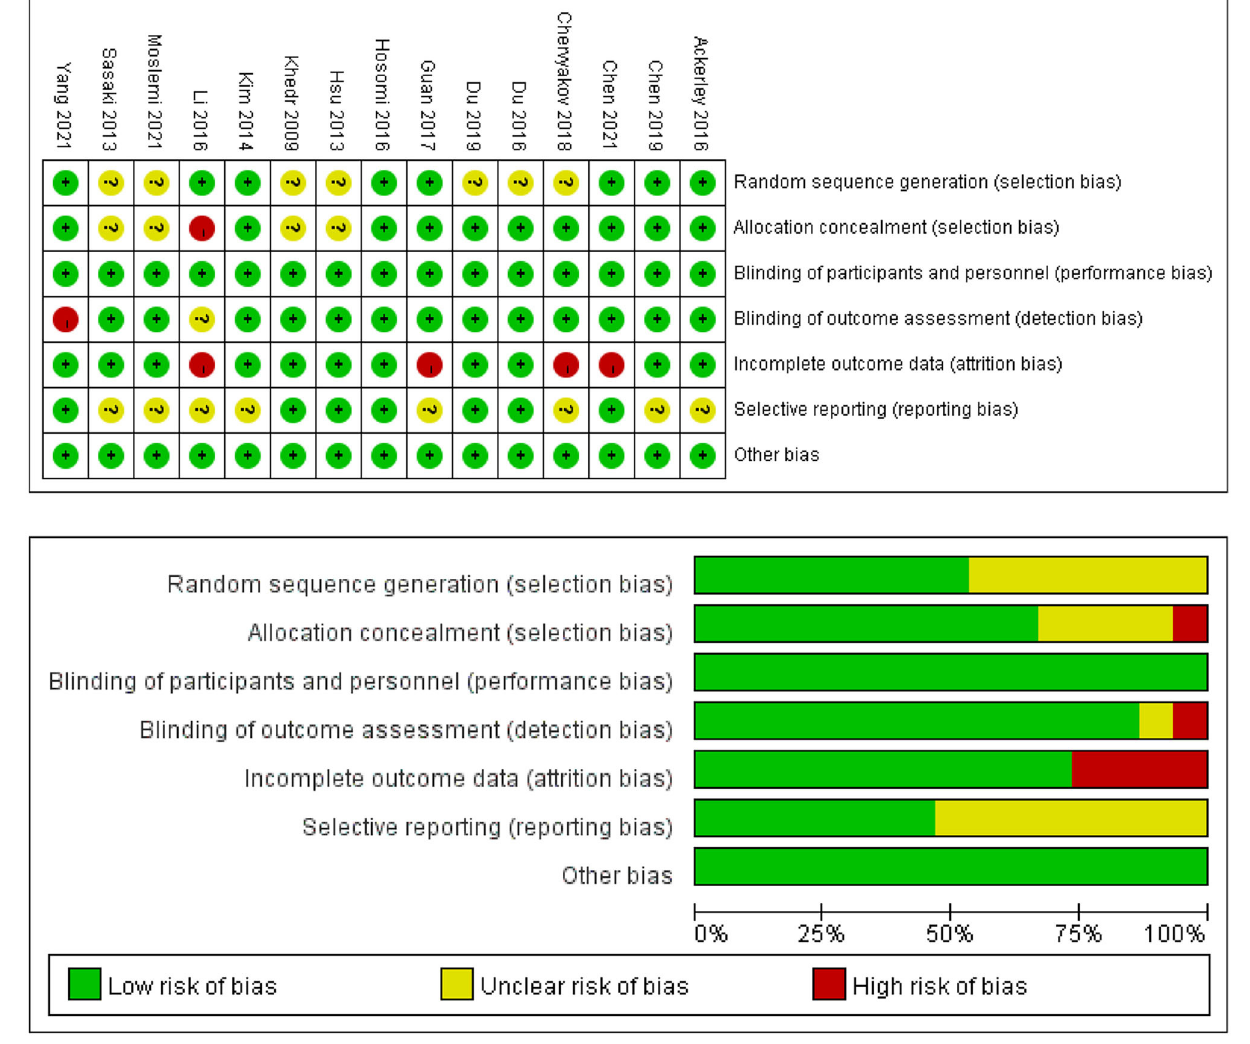
FIGURE 2 | Risk of bias summary and graph for each risk of bias item presented as percentages across all included